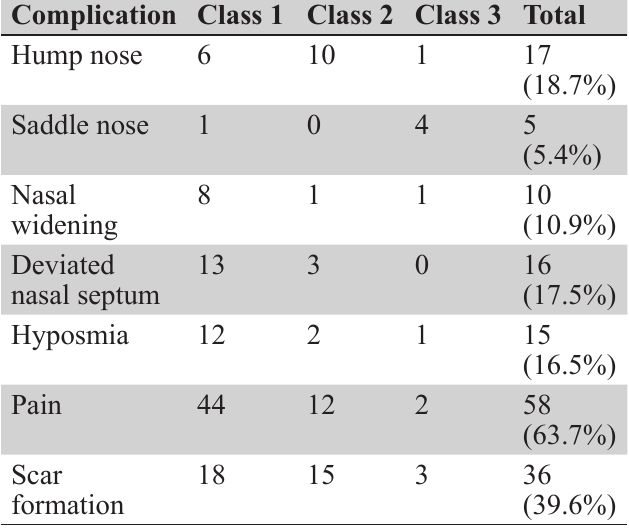
Table 3. Complications occurring in patients with nasal bone fractures.